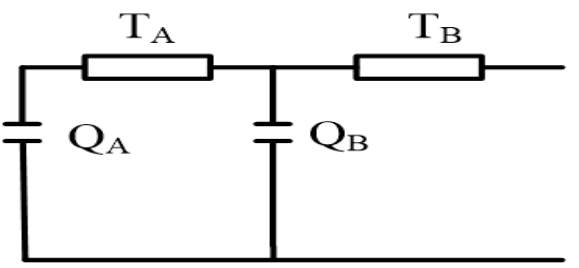
Figure 4. A two-loop ladder equivalent thermal circuit.